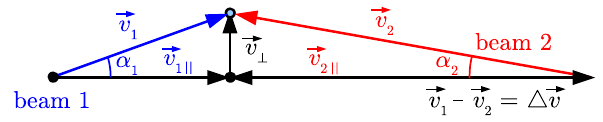
Fig. 1 Decomposition of the beam particle velocities v 1 , 2 to the per- pendicular v ⊥ and the parallel v 1 (cid:5) , v 2 (cid:5) components with respect to their difference v 1 − v 2 = (cid:2)